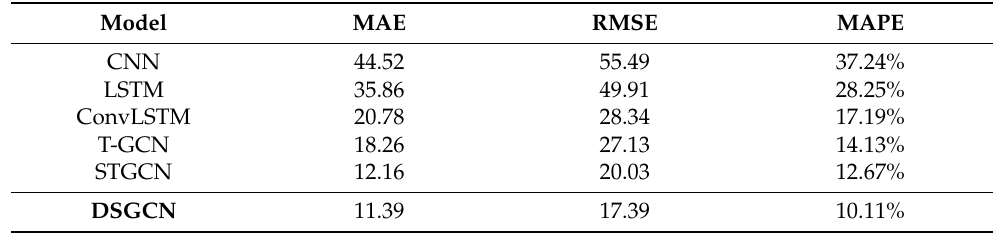
Table 2. Results of the evaluation of the DSGCN model and other baseline method models in the dataset at 30